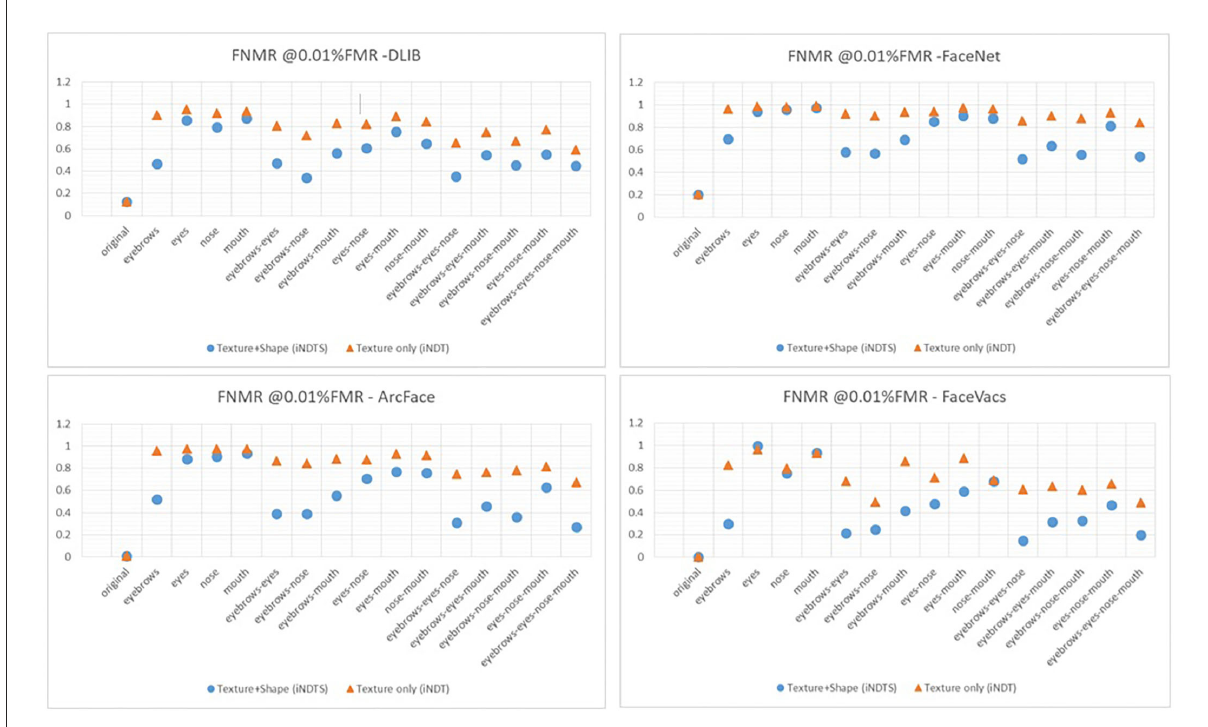
FIGURE14 The impact of texture and shape of face